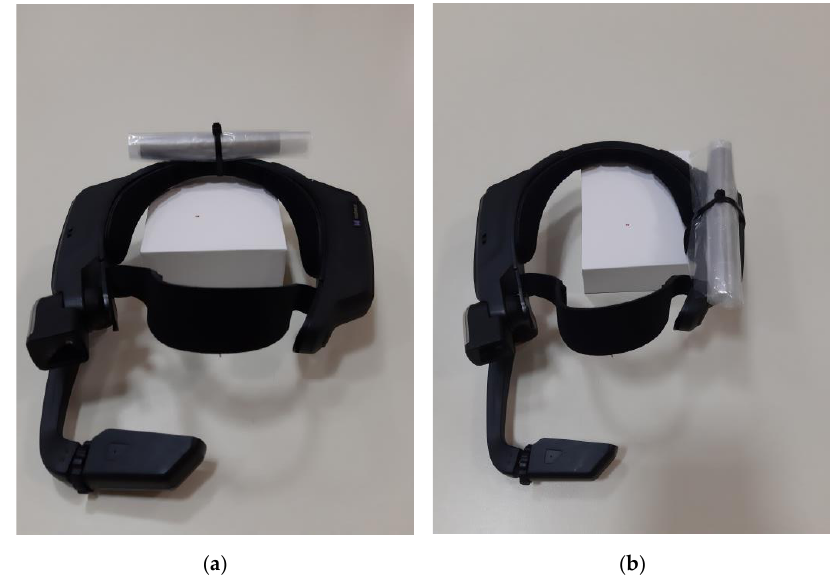
Figure 4. Battery position: ( a ) weighted-back level and ( b ) weighted-side level.